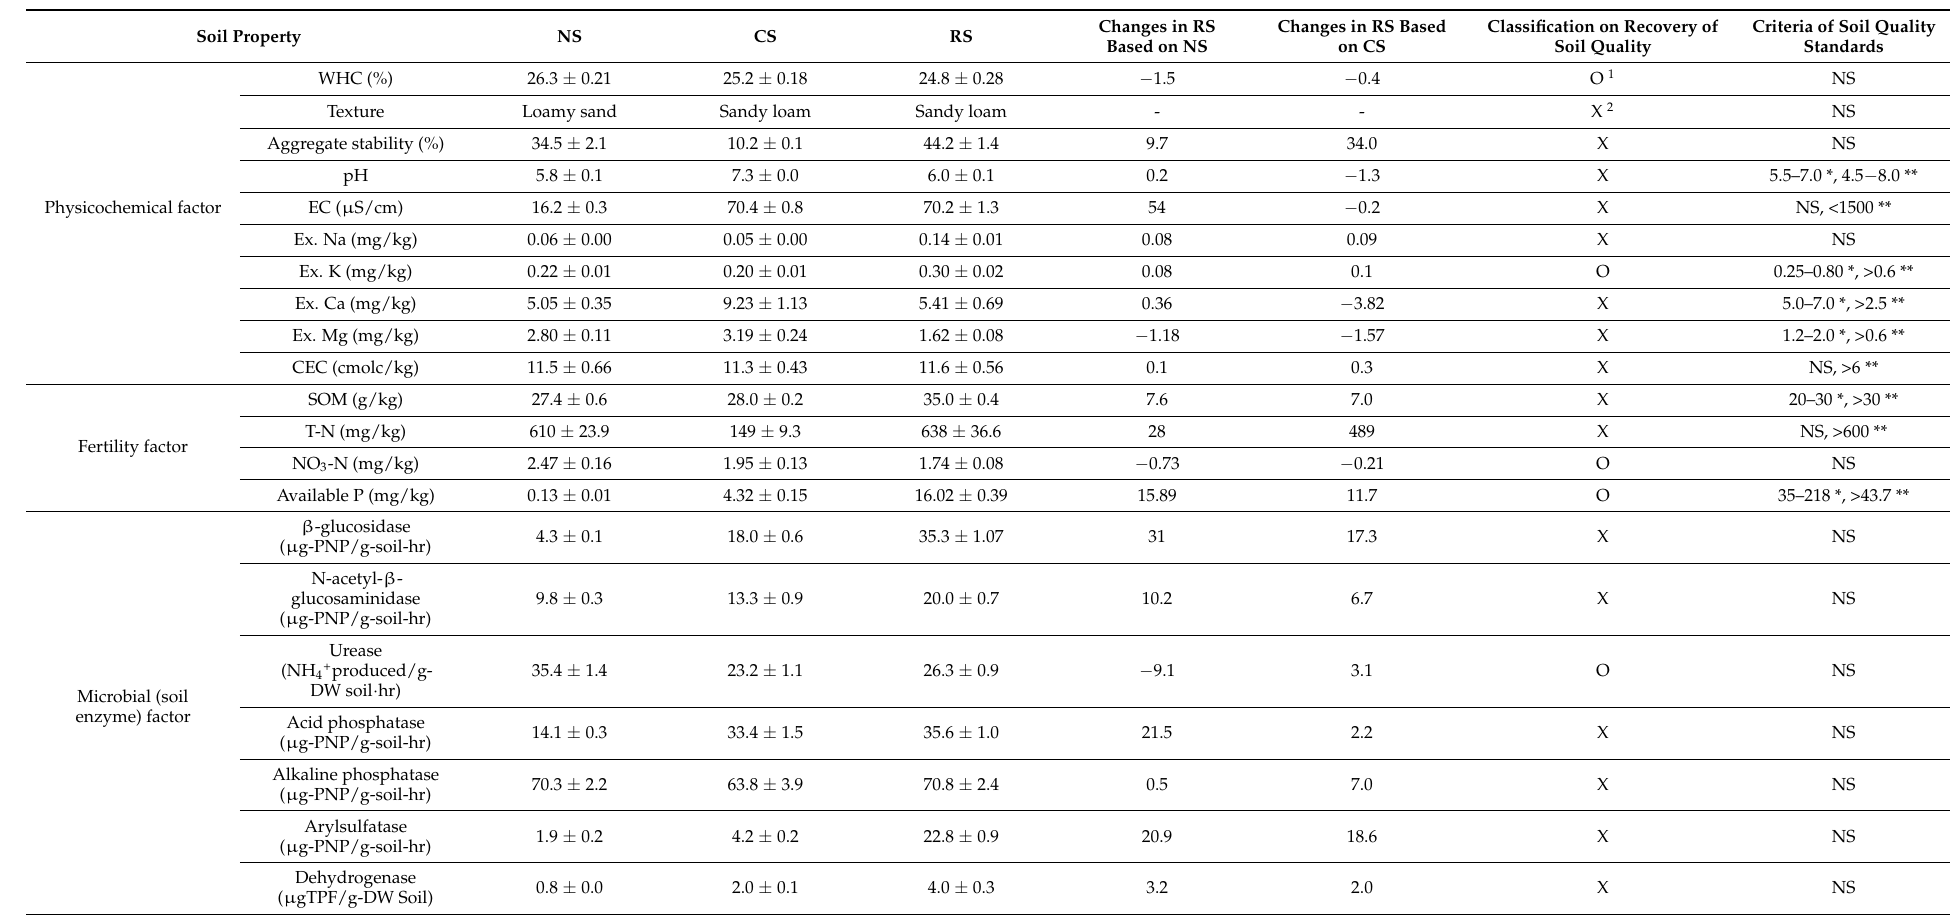
Table 3. Comparison of soil properties between non-contaminated soil (NS), contaminated soil (CS), and remediated soil (RS) and the determination of deteriorated properties which should be improved, based on the criteria of soil quality standards and the properties of